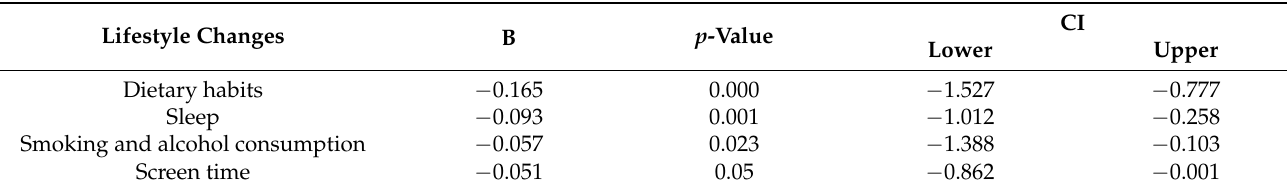
Table 2. Associations between lifestyle changes and